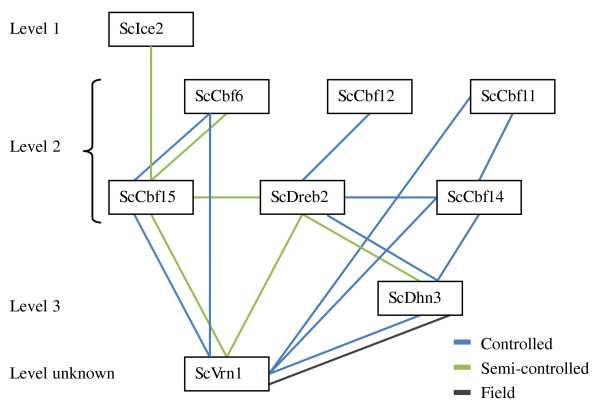
Significant (P < 0.05) gene × gene interactions for frost tolerance in three phenotyping platforms. Candidate genes are sorted in three levels according to the frost responsive cascade [19]. The level where ScVrn1 belongs to is still unknown.